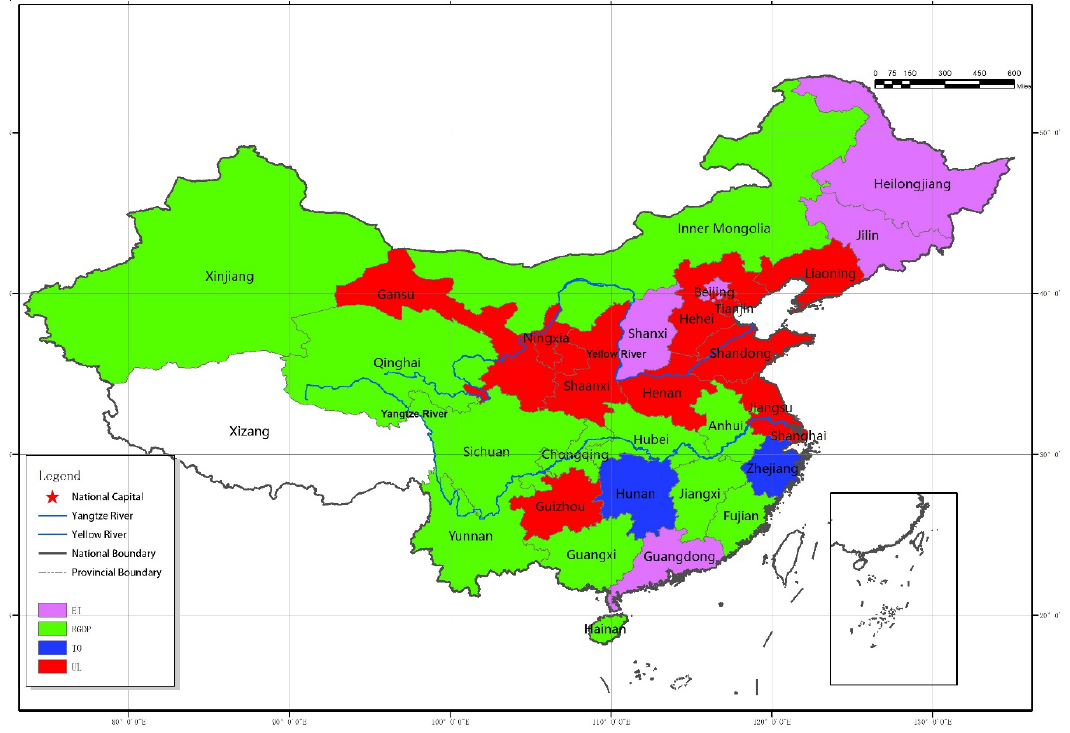
Figure 1. Regional distribution of primary influencing factors of CO 2 emissions (Note: Due to the lack of data, the Tibet region is depicted as blank.).